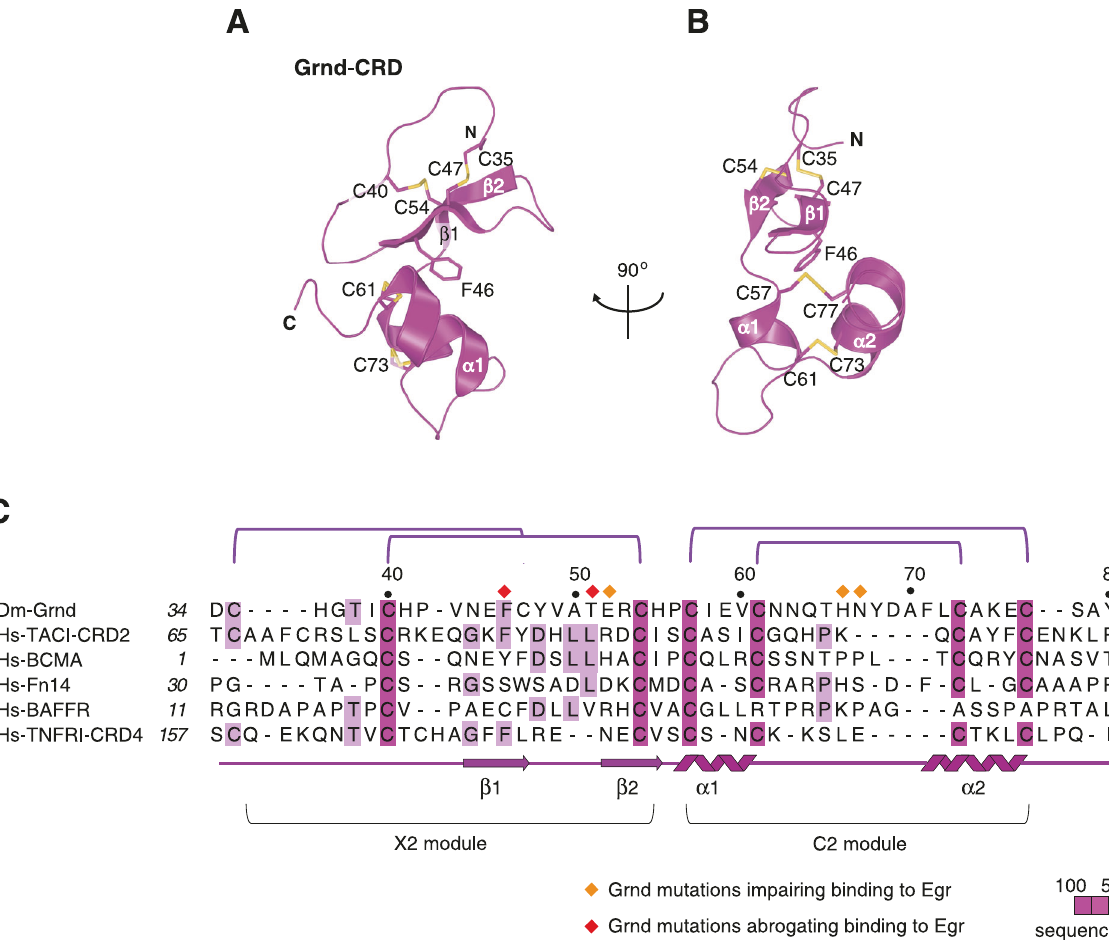
Fig. 2 Structure of the extracellular domain of Grnd. A , B Cartoon representation of Grnd-CRD viewed at the indicated orientation. Grnd is depicted in purple, with the disul fi de bonds in yellow and Phe46 in sticks. C Structure-based sequence alignment of Grnd-CRD with CRDs of TNFRs containing X2 and C2 modules, or sharing a similar conformation with Grnd, coloured by percentage of identity. Grnd disul fi de bridges are indicated as purple lines connecting cysteines numbered above the Grnd sequence. Grnd secondary structure elements are shown below the alignment. Grnd residues whose mutation impairs completely or partially binding to Egr are indicated as red or orange rhombuses,